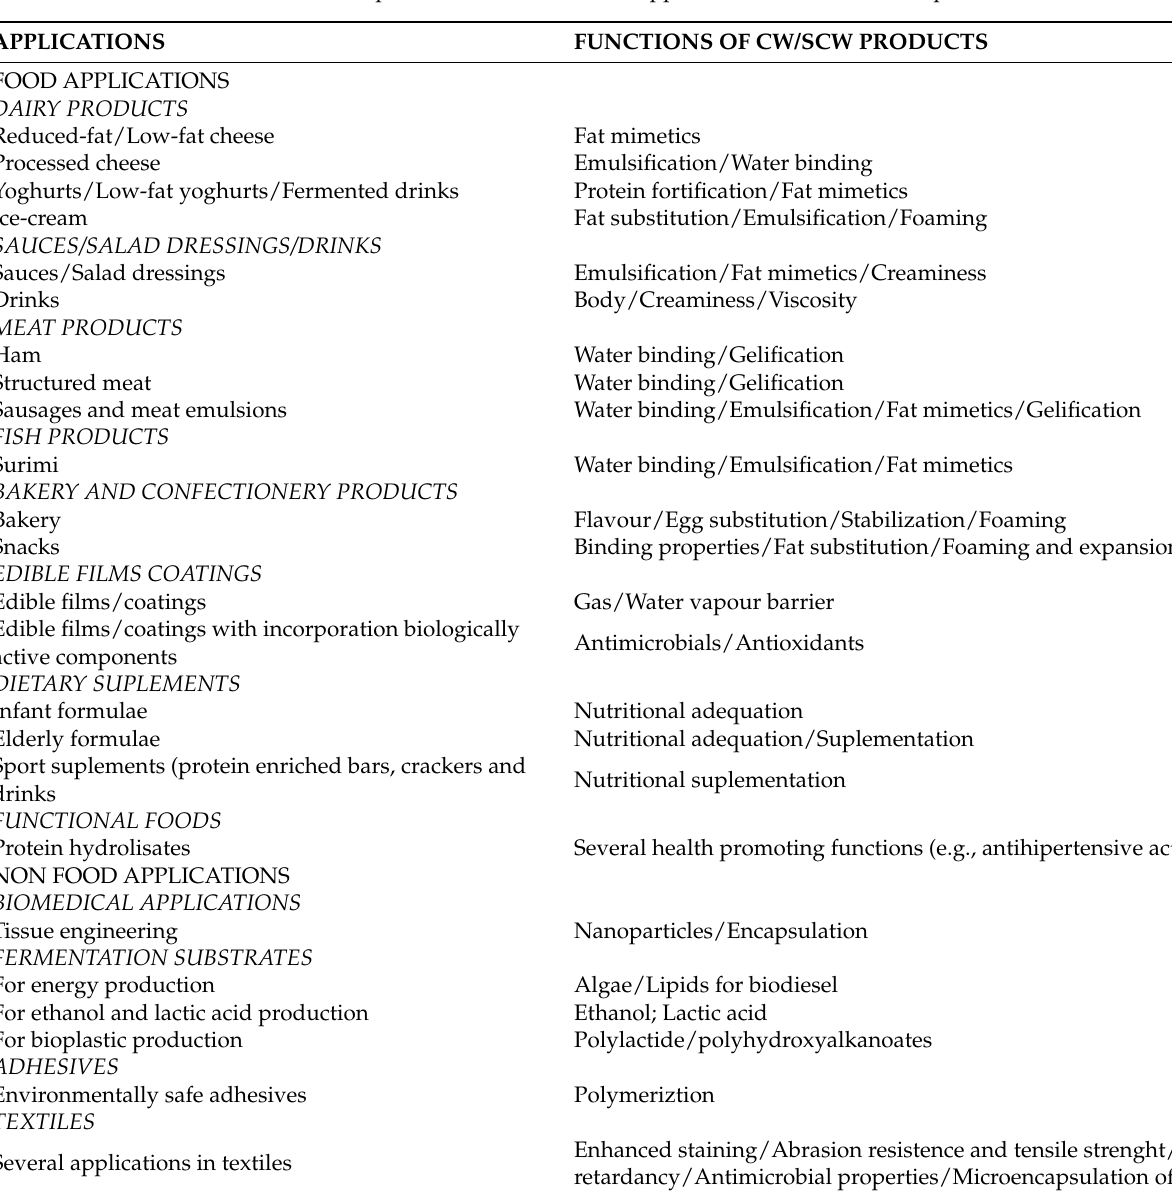
Table 4. Examples of food and non-food applications of CW and SCW